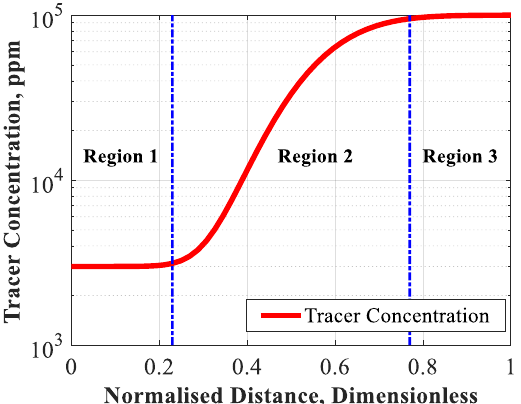
Figure 3. The obtained change by the simulation results in the tracer concentration in the mixing zone. Region 1 and Region 3 represent the dominant regions by low and high tracer concentrations, respectively. Meanwhile, Region 2 represents the beginning of the interaction between the two tracers.